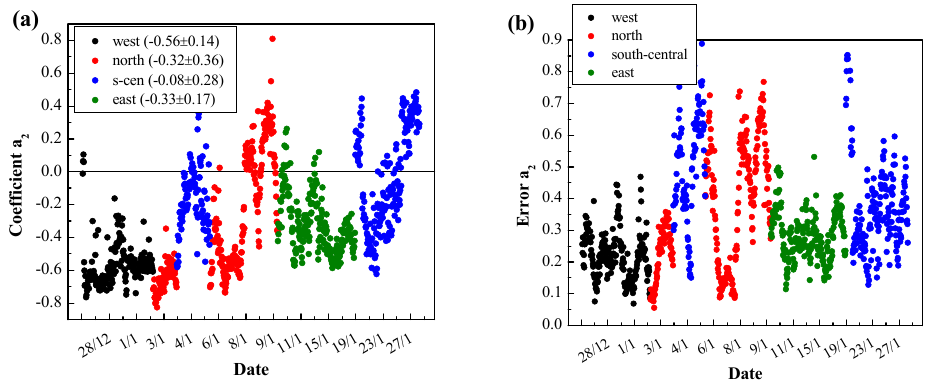
Fig. 3. Temporal variation of the coefficient a 2 (a) and its error (b) values over different BoB sub-regions during W-ICARB cruise campaign. The mean a 2 values along with the standard deviations are given for each sub-region.